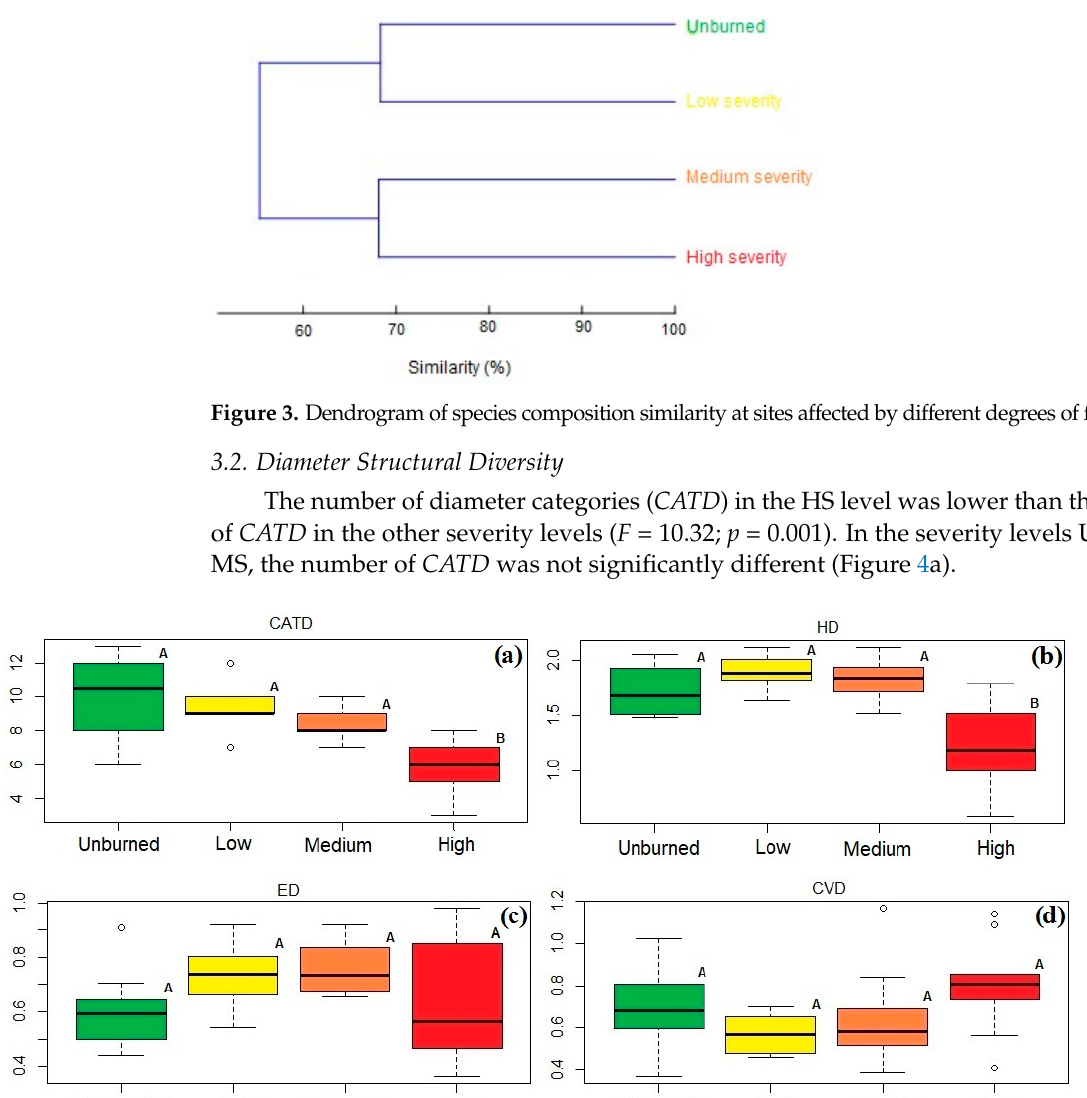
Figure 3. Dendrogram of species composition similarity at sites affected by different degrees of fire severity.